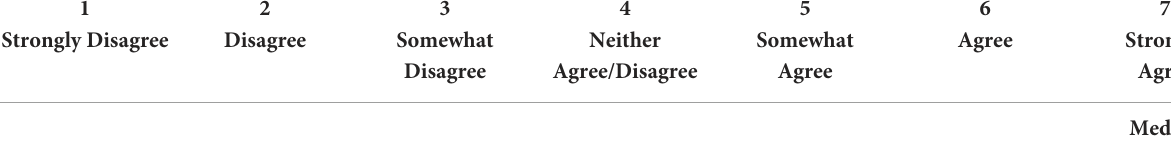
TABLE 1 Medians and distributions of responses to questions regarding team- and service-learning were each significantly different from neutral (i.e., 4.0, N = 43, p < 0.0001, question 8 p =